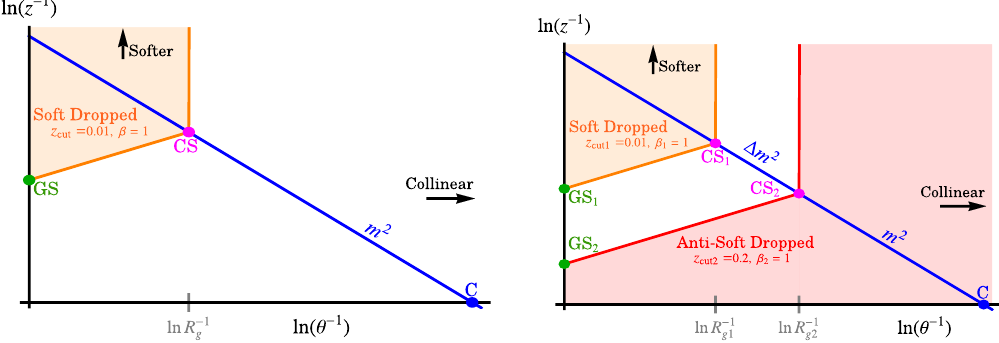
Figure 2 . Phase space regions in the plane of energy fraction ( z ) and polar angle from the jet axis ( (cid:18) ), where the white regions are those that are kept. The left panel shows the result for soft drop where the orange shaded region is eliminated. The right panel shows the result for collinear drop where in addition the red shaded region is eliminated. In SCET the relevant degrees of freedom are collinear (C) modes, collinear-soft (CS) modes, and global soft (GS) modes, shown by solid